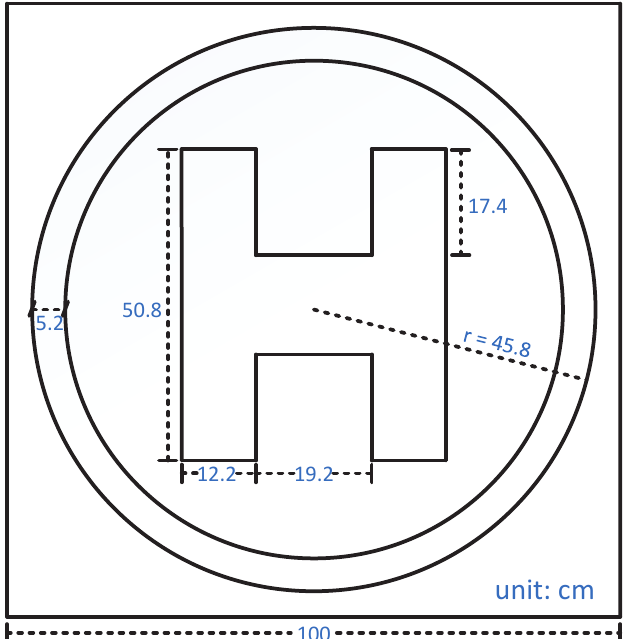
Figure 3. Details of the scaled international landing